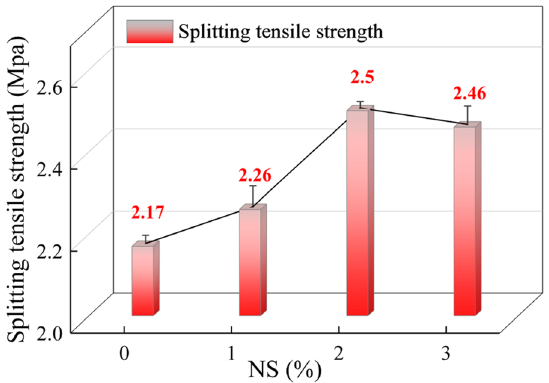
Figure 10: E ff ect of NS concentration on the splitting tensile strength of RAC.